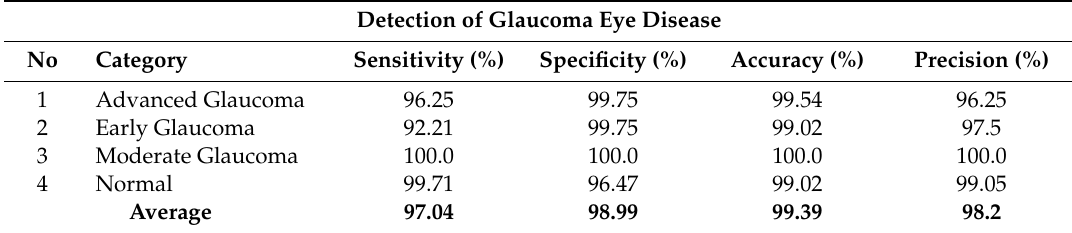
Table 5. Computed Values (%) of Statistical Measures on the Local Retinal Glaucoma Image Dataset.